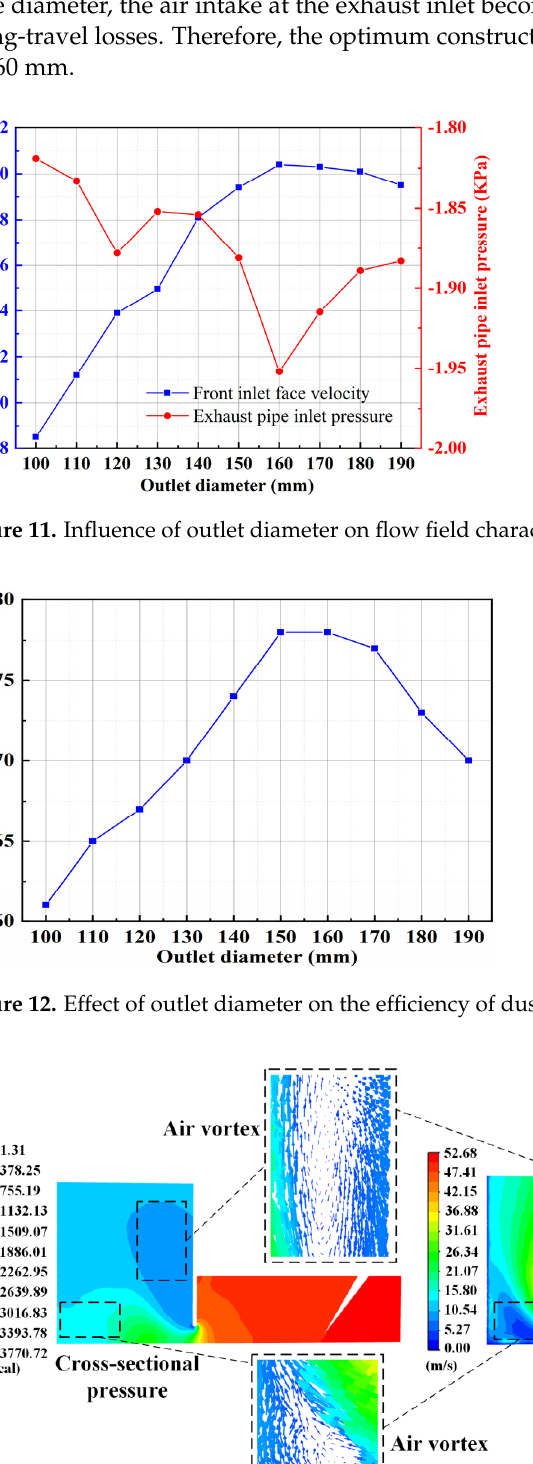
11 of 17 Figure 10. Comparison of particle trajectories for different sizes of dust extraction ports. Figure 11 shows the effect of outlet diameter on the characteristics of the flow field. As can be seen from the figure, as the outlet diameter increases, the forward gas surface velocity increases and then decreases slightly, and the pressure at the exhaust inlet in- creases, then decreases, then starts to increase again and finally decreases. When the outlet diameter is 160 mm, the forward air surface velocity and the pressure at the exhaust inlet